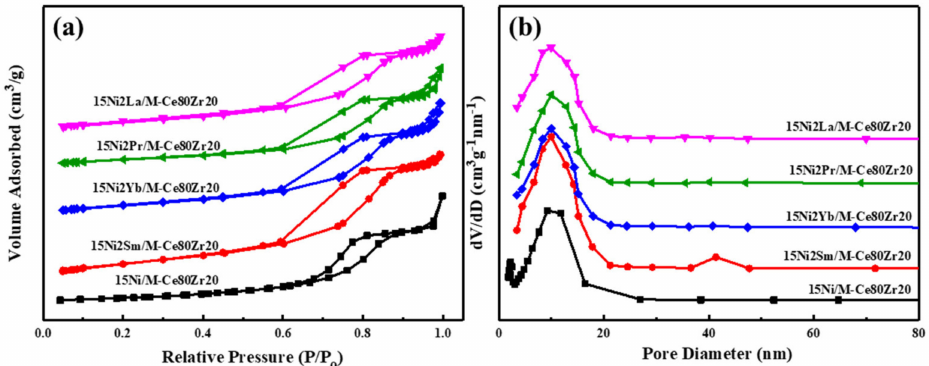
Figure 2. N 2 adsorption-desorption isotherms ( a ) and pore size distributions ( b ) of the 15Ni2R/M-Ce80Zr20 (R = La, Sm, Pr, Yb) catalysts.